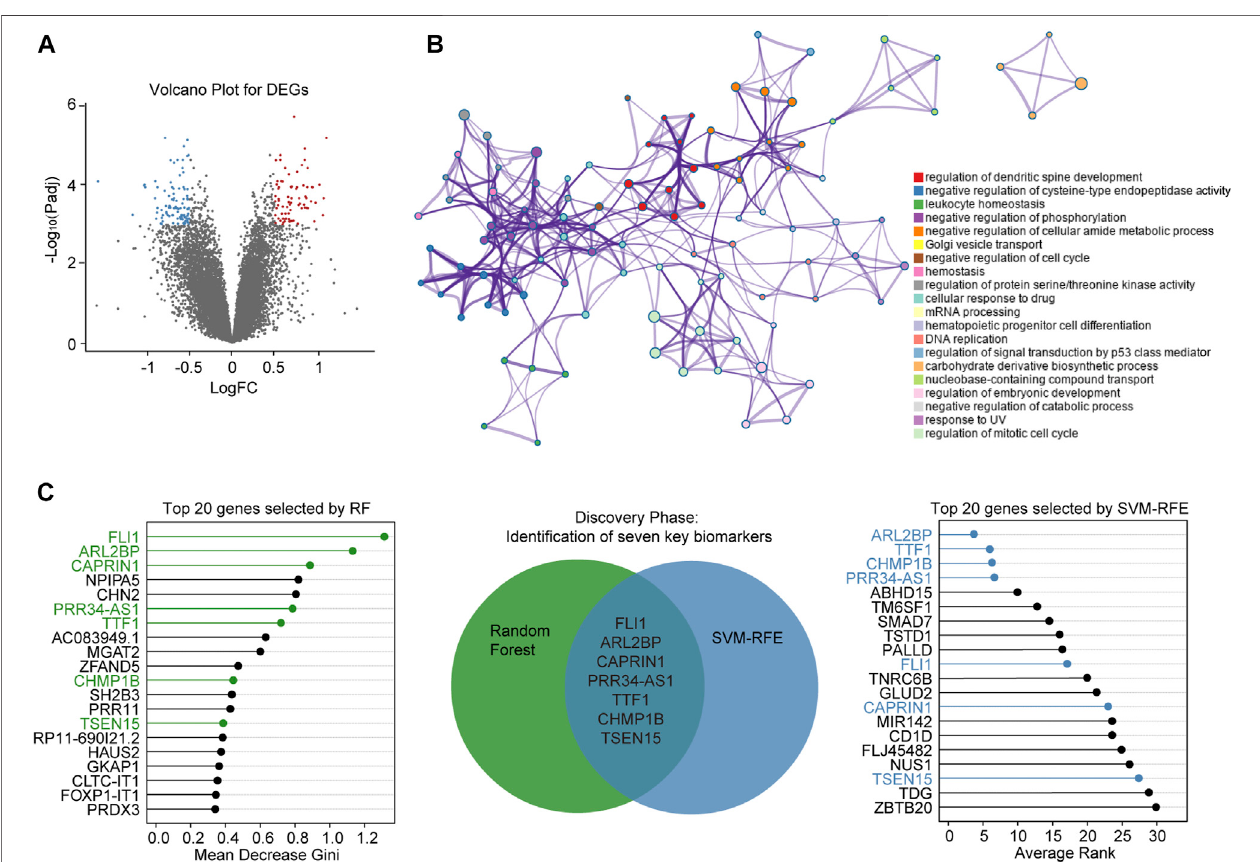
FIGURE 3 | Screening of diagnostic biomarkers for AR (A) Volcano plot shows DEGs between AR and non-AR peripheral blood samples. Blue dots denote downregulatedgenes,andreddotsdenoteupregulatedgenes (B) Networkoftop20enrichedclusters,whereeachnoderepresentsonestatisticallysigni fi canttermand terms with similarity of more than 0.3 are connected by edges (C) Lollipop chart shows top-ranked 20 genes ordered by Gini-importance through RF on the left side of the fi gure, while the same number of genes ranked by SVM-RFE are shown on the right side of the fi gure. Venn diagram for seven simultaneously top-ranked biomarkers is in the middle part, the green and blue circles represent DEGs selected by RF and SVM-RFE, respectively. DEGs: differentially expressed genes. FC: fold change. RF: random forest.